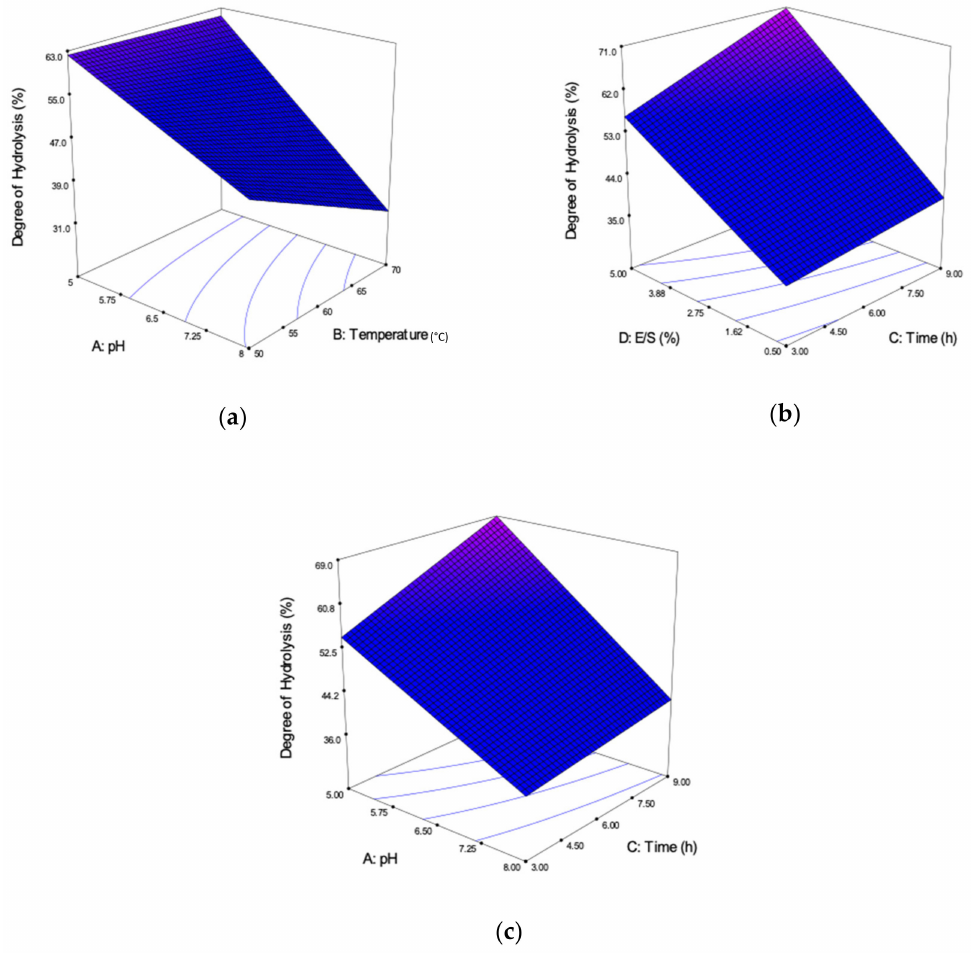
Figure 2. Three-dimensional (3D) contour plots showing the influence of variable parameters on the degree of hydrolysis (DH) response. ( a ) pH vs. reaction temperature, ( b ) reaction time vs. E / S ratio and ( c ) pH vs. reaction